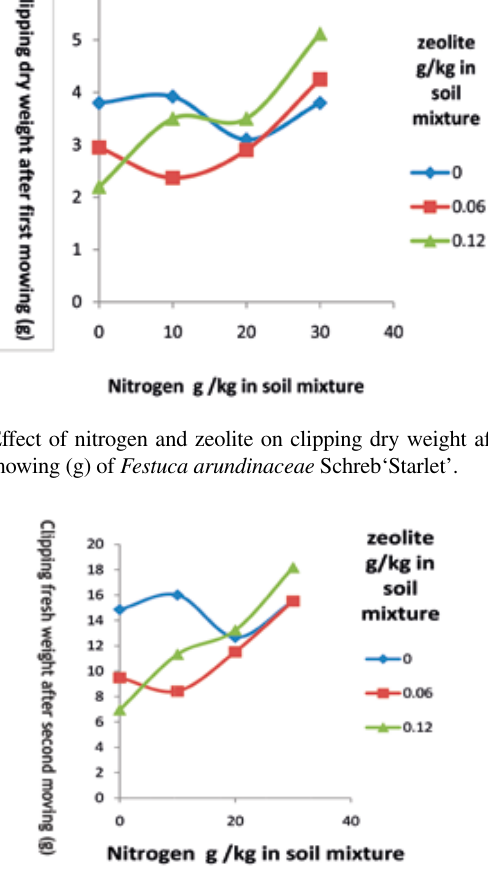
Fig. 3 - Effect of nitrogen and zeolite on clipping fresh weight after sec- ond mowing (g) of Festuca arundinaceae Schreb‘Starlet’.